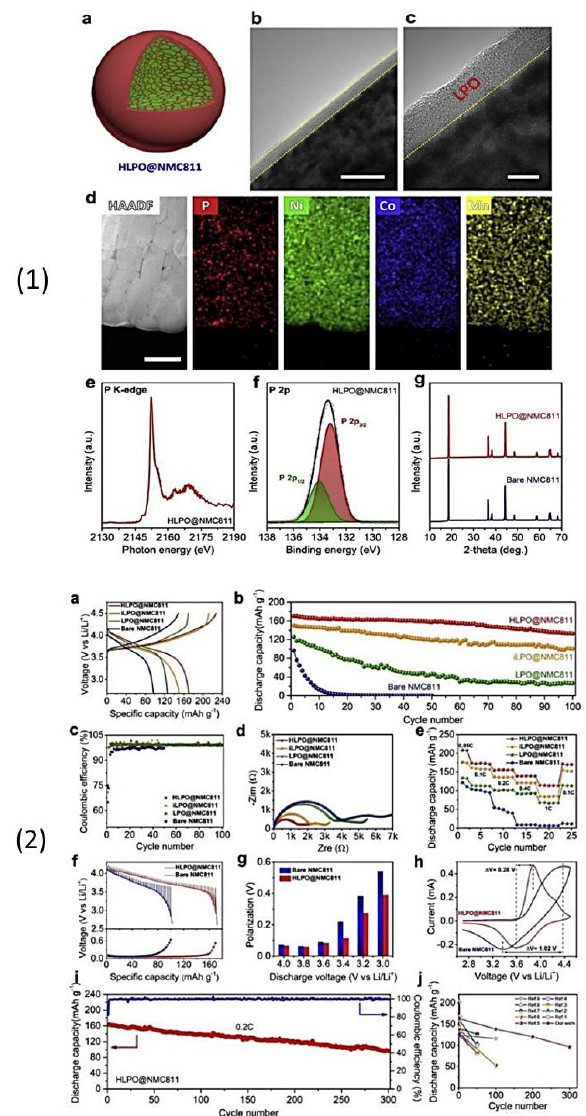
Figure 18. ( 1 ) ( a ) Schematic illustration of the detailed structure of HLPO@NMC811, ( b – c ) HR-TEM images of the secondary LPO coating layer on the HLPO@NMC811 surface at different magnifications, ( d ) EDX mappings of the cross-sectional HLPO@NMC811, ( e – f ) P K-edge XANES and P 2p XPS spectra of HLPO@NMC811, ( g ) XRD patterns of the bare NMC811 and HLPO@NMC811. Scale bars in ( b ), ( c ), and ( d ) are 20 nm, 5 nm, and 500 nm, respectively. ( 2 ) Effectiveness of various Li 3 PO 4 modifications for the performance of all-solid-state Li-ion batteries. ( a ) First cycle charge–discharge curves, ( b ) cycling stabilities at the current rate of 0.1C, ( c ) corresponding Coulombic efficiencies, ( d ) electrochemical impedance spectroscopy plots after 100 cycles, and ( e ) rate capabilities of four types of NMC811 cathodes. ( f ) Galvanostatic intermittent titration technique curves during the discharge process (top) and corresponding polarization plots (bottom), ( g ) polarization plots at selected discharge voltages, ( h ) cyclic voltammetry profiles at the first cycle of the optimal HLPO@NMC811 and bare NMC811 cathodes. ( i ) Long-term cycling stability of HLPO@NMC811 cathode at 0.2C. ( j ) Cycling performance of the Ni-rich Li(Ni x Mn y Co z )O 2 cathodes in sulfide-based all-solid-state Li-ion batteries. Reproduced with permission from [280]. Copyright 2020 Elsevier.